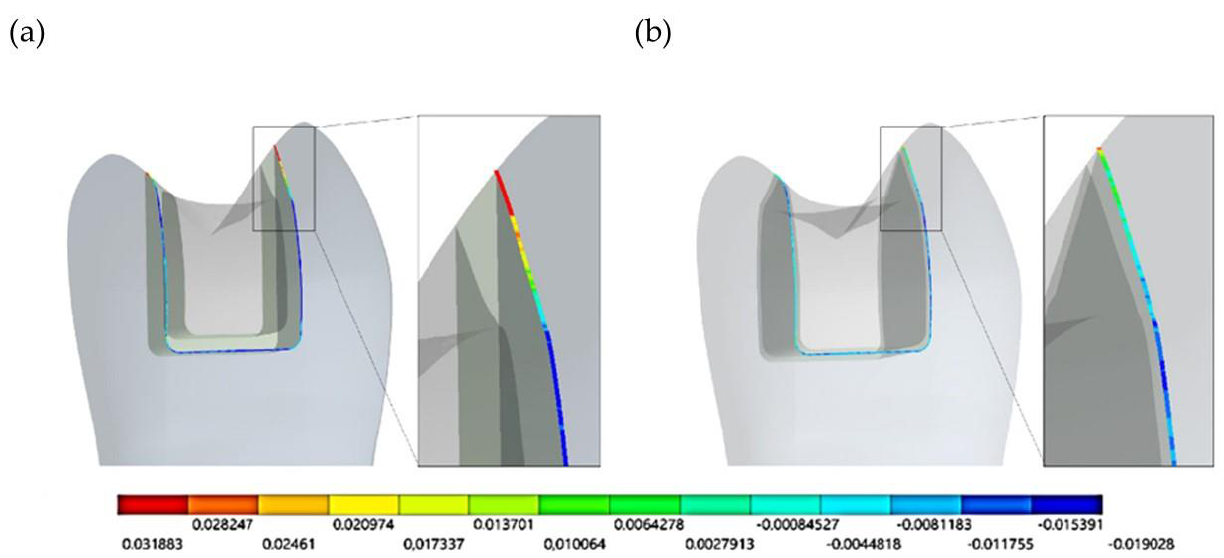
Figure 8. Maximum principal stress at the cavity margin with ( a ) 400 μm cement thickness model and ( b ) 100 μm cement thickness. The stress concentration was higher at the vestibular occlusal region.